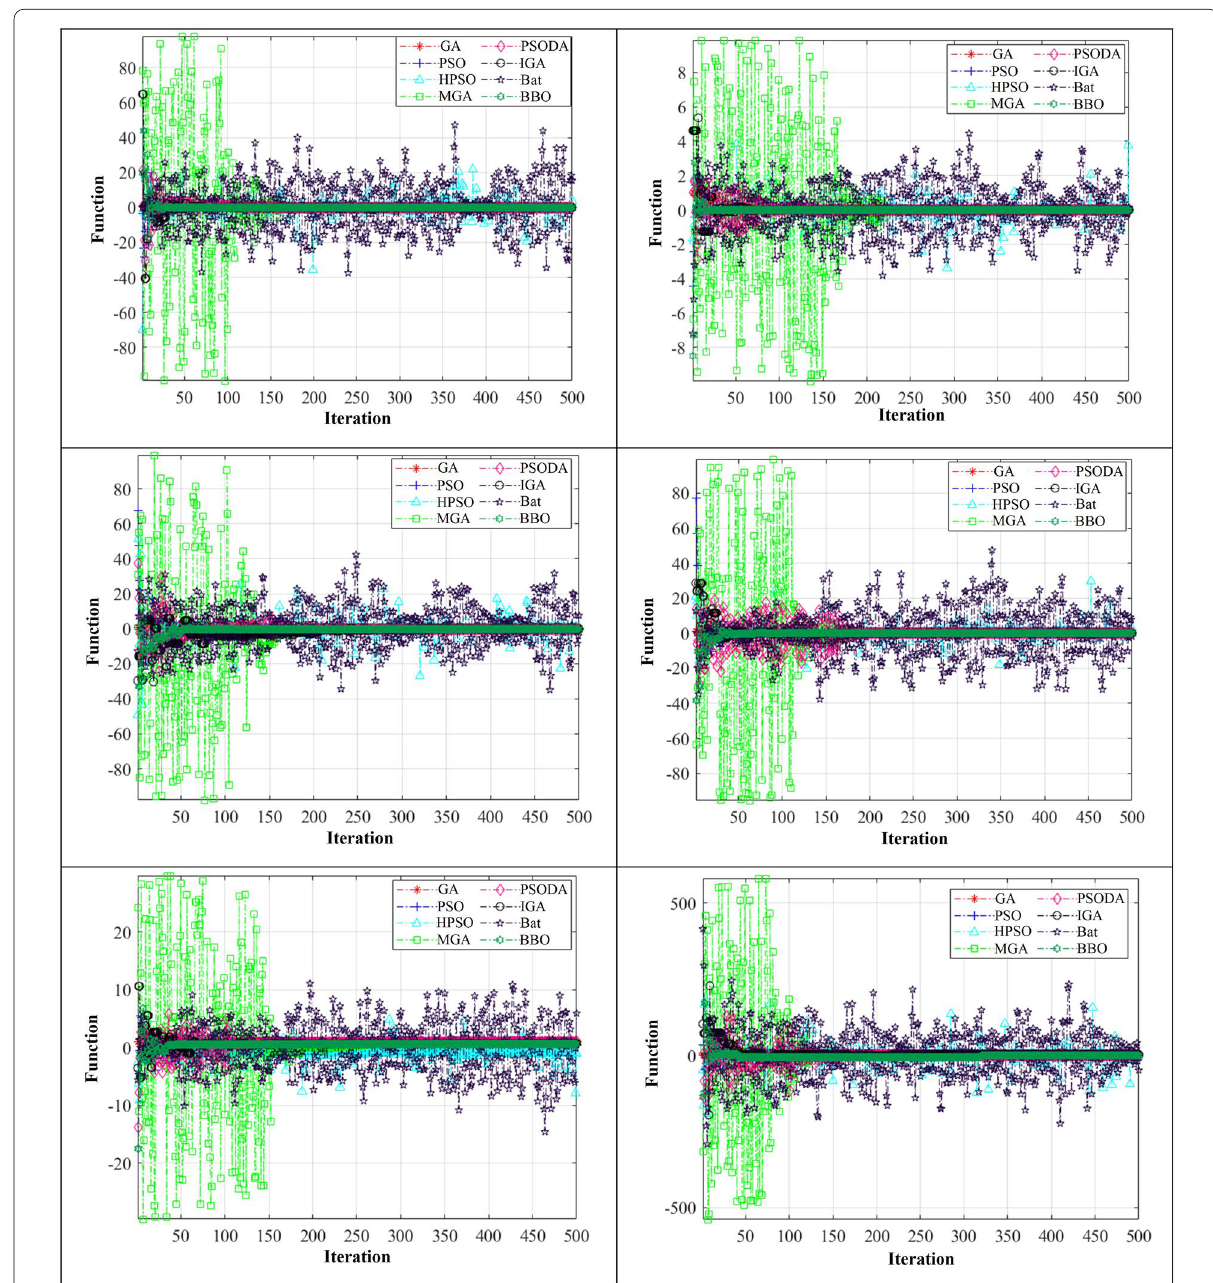
Fig. 7 The trajectory of different compared